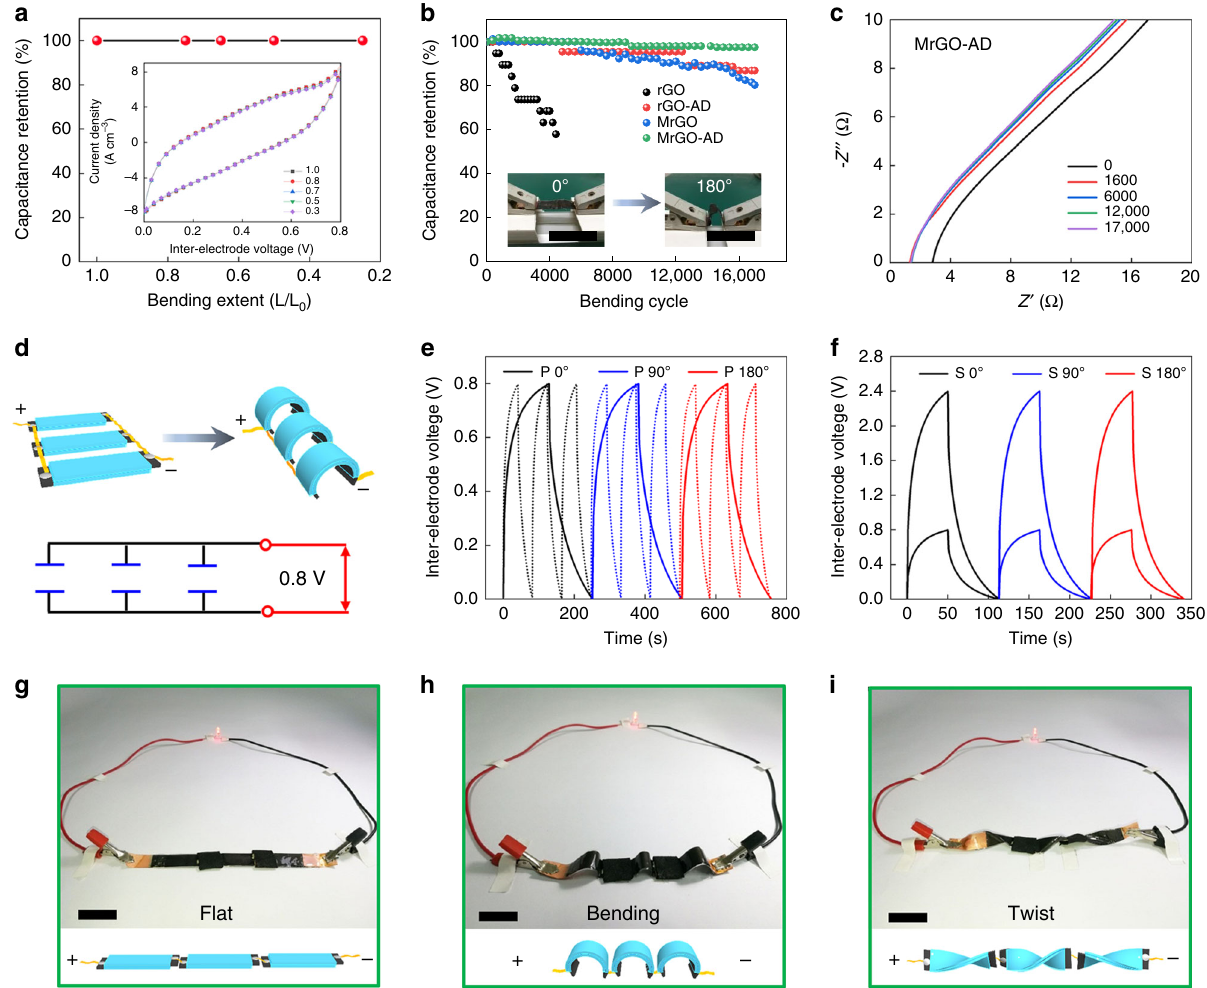
Fig. 5 The effect of severe bending of a supercapacitor. a Capacitance retention as a function of the bending extent of the supercapacitor (which is de fi ned as the ratio of the end-to-end separation in the bent supercapacitor to this separation for the non-bent supercapacitor). b Capacitance retention for supercapacitors based on rGO, rGO-AD, MrGO, and MrGO-AD sheets during up to 17,000 bending cycles to a bending extent of 25% (which corresponds to a 180° angle between supercapacitor ends). Scale bar, 2 cm (inset). c Nyquist plots for a MrGO-AD supercapacitor, which were measured after various cycles of bending to the 180° angle of b. d Schematic diagram of three in-parallel MrGO-AD supercapacitors (both unbent and with 180° angle bending) and the corresponding circuit diagram. Galvanostatic charge-discharge curves for three e in-parallel and f in-series MrGO-AD supercapacitors. g – i In-series operation of three MrGO-AD supercapacitors to light an LED (~1.7 V) when in g, fl at. h, 180° bent. i in twisted states. Scale bar, 2 cm ( g – i